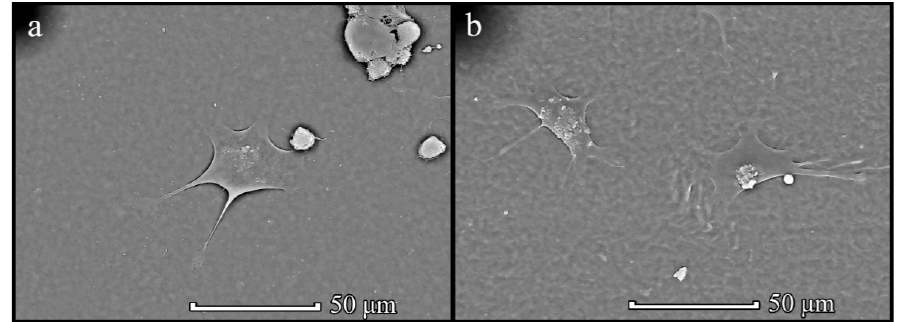
Figure 12. SEM images of MSCs PHB350 ( a ) and PHB- co -HV(17%) ( b ) films.